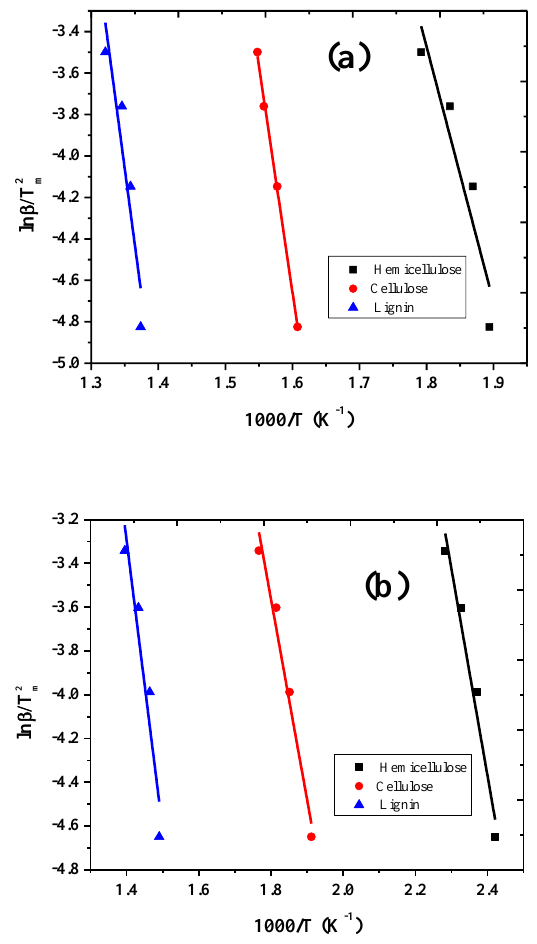
Figure 5. Plots constructed from decomposition of karanja press cake applying the Kissinger method: ( a ) in absence of catalyst; ( b ) in presence of catalyst .